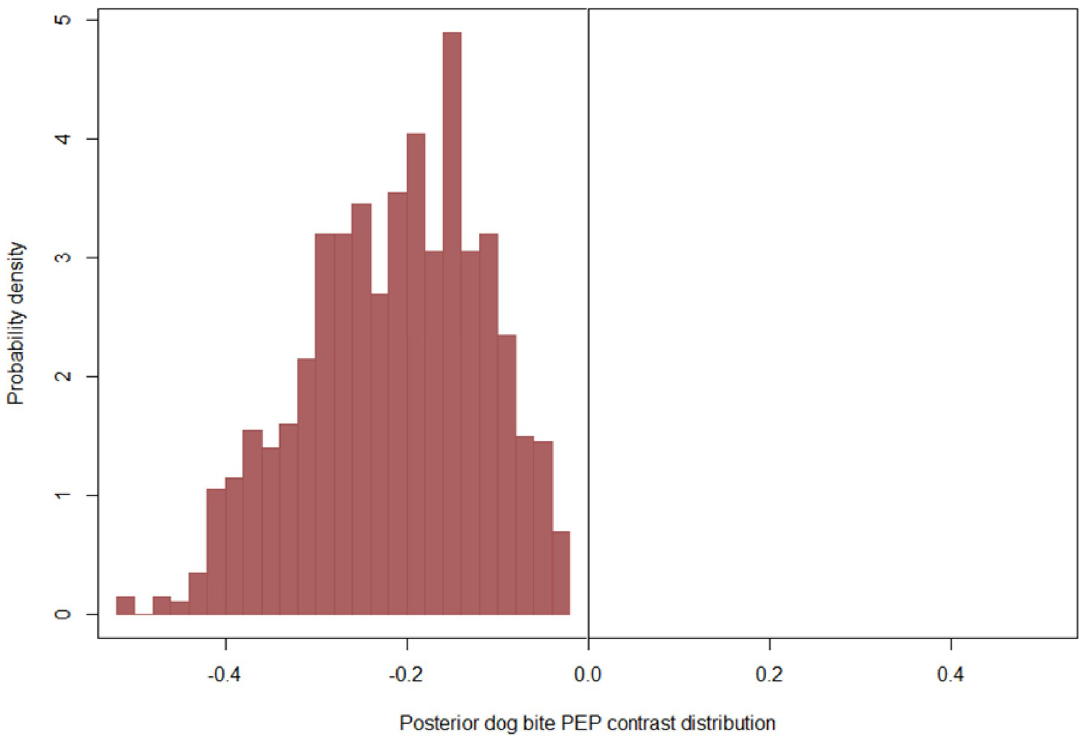
Fig 3. Posterior marginal contrast distribution demonstrating the estimated posterior probability of deaths was predicted to change when comparing victims who received PEP and those who did not.